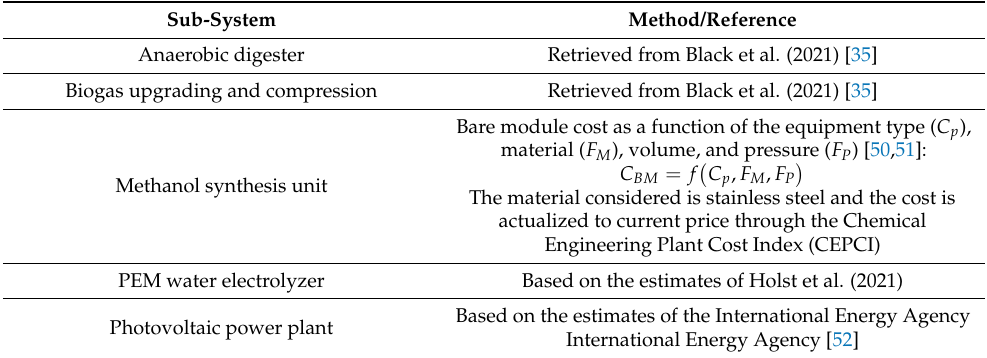
Table 3. Methods and references for cost estimation of the main components of the hybrid methanol– methane